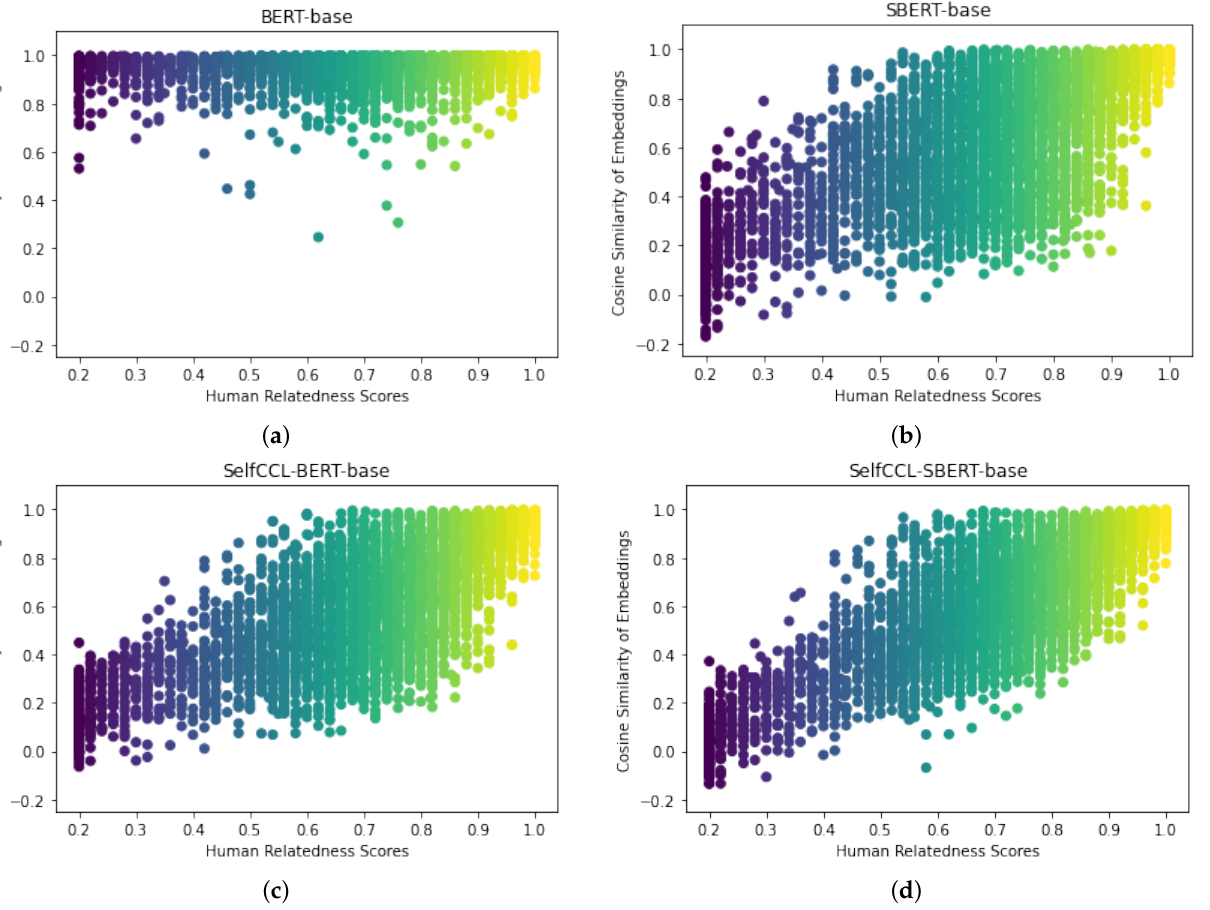
Figure 4. Scatter plots of cosine similarity of sentence embeddings and human relatedness scores on SICK test split for ( a ) BERT, ( b ) SBERT, ( c ) SelfCCL-BERT, and ( d ) SelfCCL-SBERT models. The color coding corresponds to the human relatedness